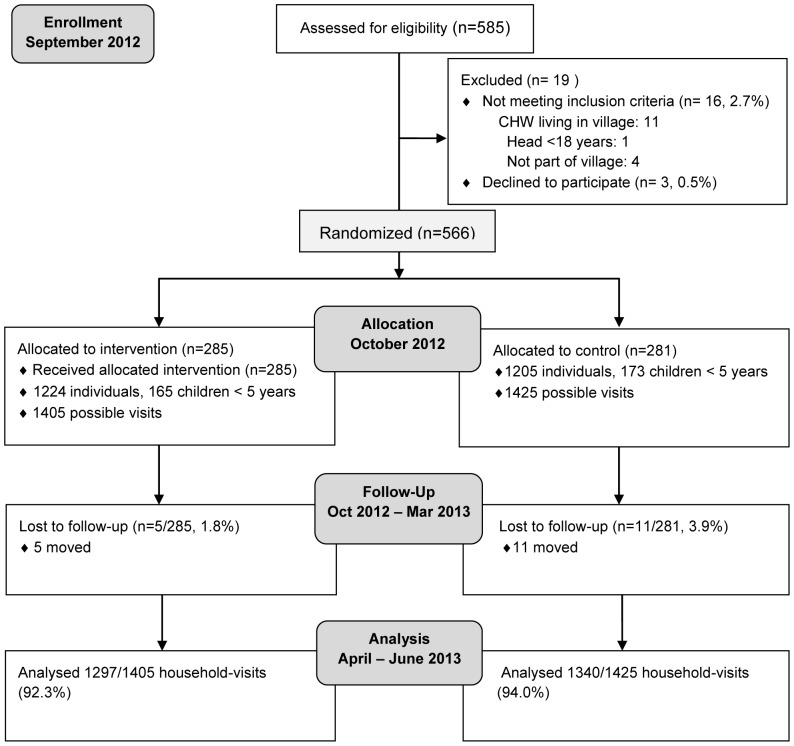
CONSORT diagram showing the flow of participants through the trial.